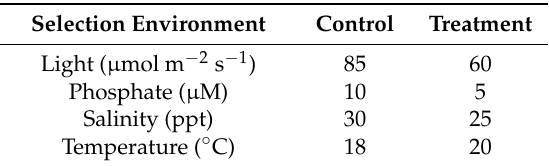
Table 1. A comparison of the control environment and the treatments used for each selection environment used in this